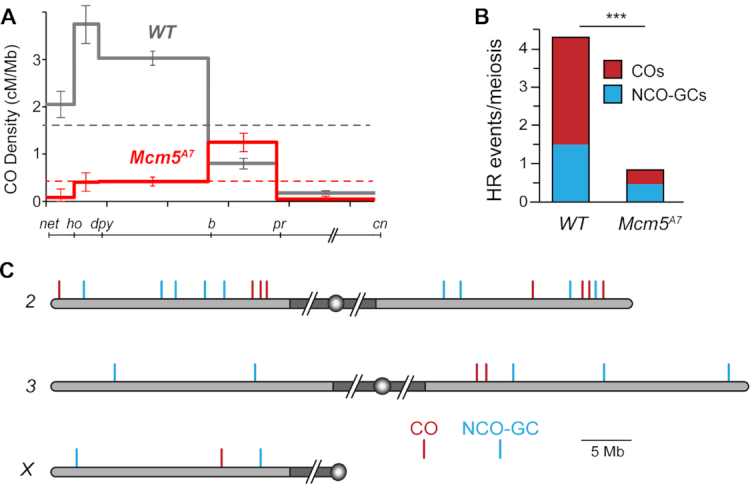
Homologous recombination is severely reduced in Mcm5A7 mutants. (A) Crossover density (cM/Mb) across 2L in wild-type females and Mcm5A7 mutants (n = 2070). Dashed lines represent mean crossover density across the region assayed. Error bars indicate 95% confidence intervals. The line below the graph shows the markers used along 2L and 2R (slashes represent the centromere and pericentric heterochromatin, which are not included). (B) Number of crossovers (COs) and noncrossover gene conversion events (NCO-GCs) per meiosis in wild type (n = 196 meioses, dataset from Miller et al. (42) and Mcm5A7mutants (n = 28 meioses). ***P < 0.0001, one sample t-test, two-tailed. (C) COs and NCO-GCs identified by WGS of individual males from Mcm5A7 females. Gray shaded area represents euchromatic sequence, while dark gray shaded area represents the pericentric heterochromatin (not to scale), circles represent centromeres. 2L is vertically aligned with the graph in panel (A).